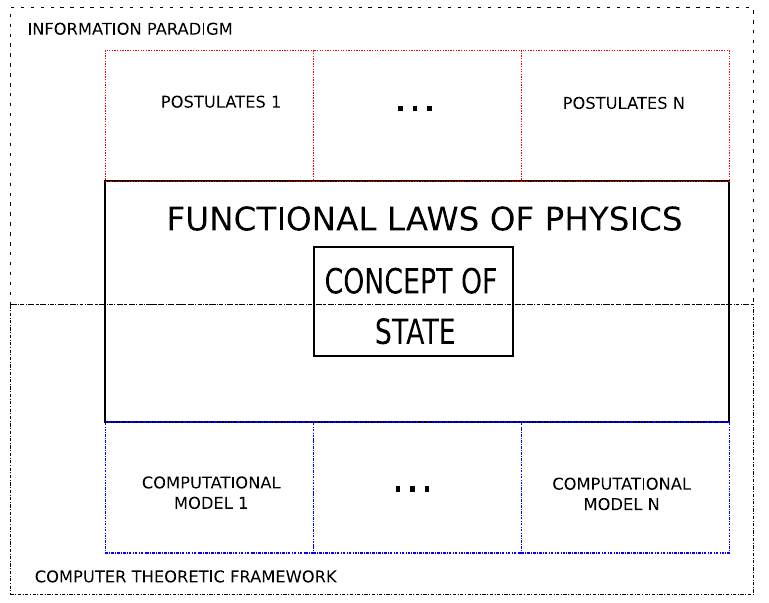
Figure 2. Graphical representation of the relationship between the information paradigm and the computer-theoretic framework, addressing the study of a functional theory of physical phenomena. A relationship of complementarity is depicted because both paradigms address different issues, and both issues are directly related to the concept of